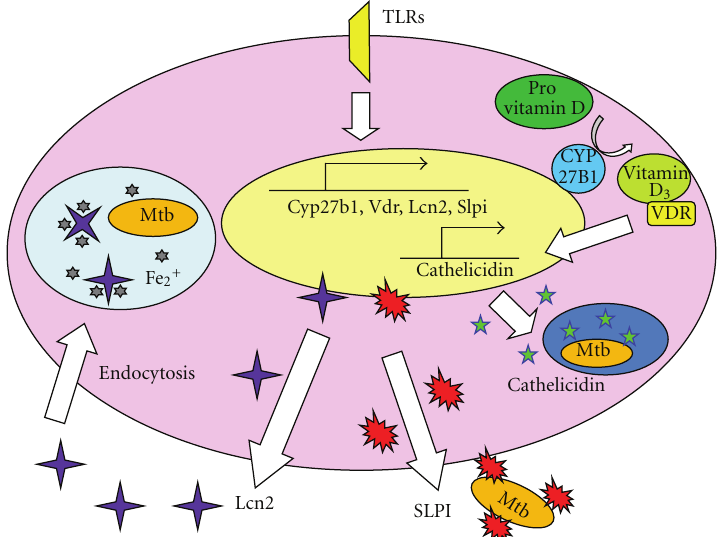
Figure 3: TLR-dependent innate response to mycobacteria. Several TLR-dependent gene products mediate innate immune responses to mycobacteria. Mycobacterial stimulation of TLR2 induces expression of Cyp27b1 and vitamin D receptor (VDR), both of which are involved in vitamin D 3 -dependent induction of cathelicidin which directly kills mycobacteria. TLR-dependent induction of SLPI mediates disruption of the mycobacterial cell wall. Lcn2, which is also induced by TLR stimulation, is internalized into the alveolar epithelial cells and inhibits mycobacterial growth by sequestering iron